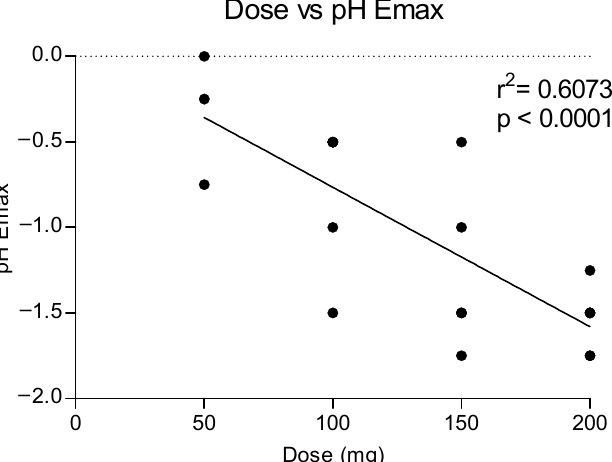
Figure 5. Correlation between methylone doses and maximum e ff ects on pH (Emax).